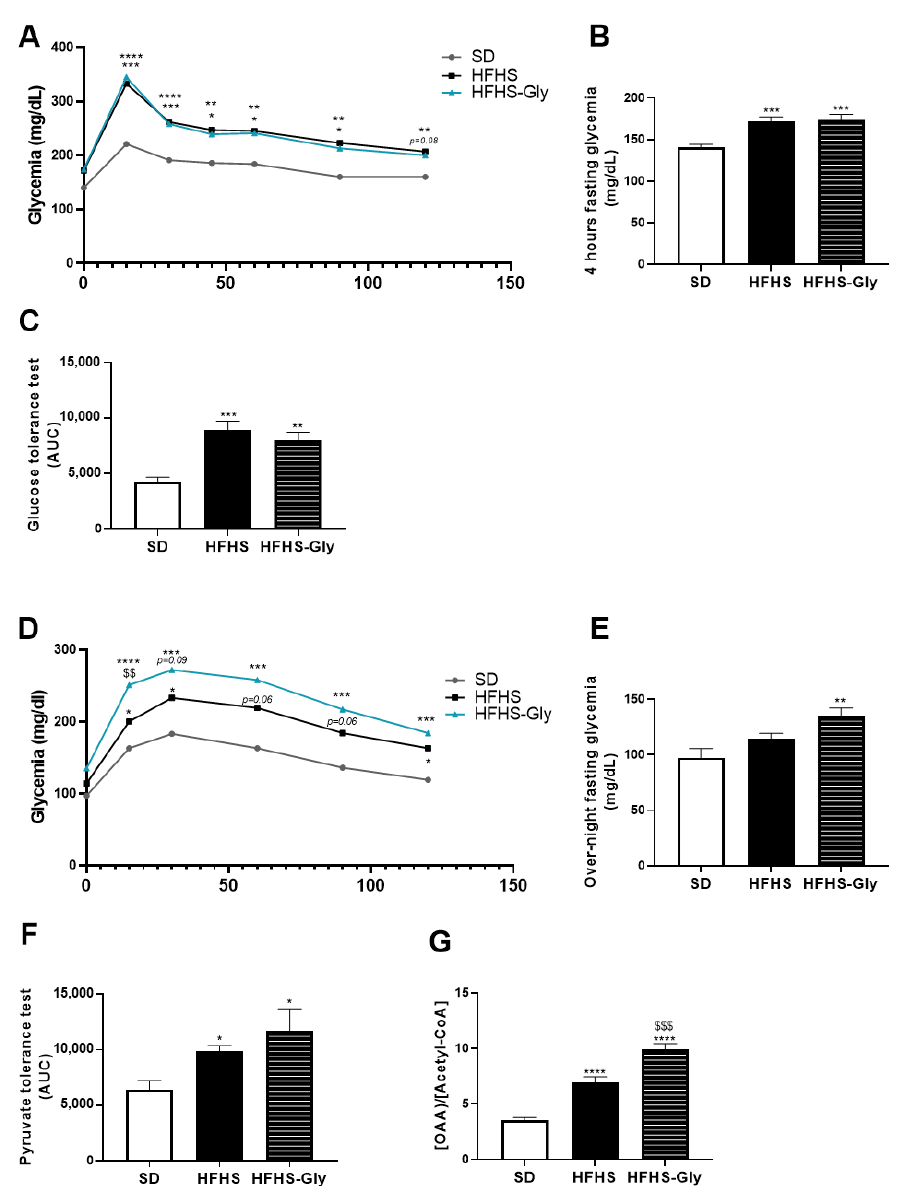
Figure 4. The impact of obesogenic diet and glycine on glucose and pyruvate tolerance tests.